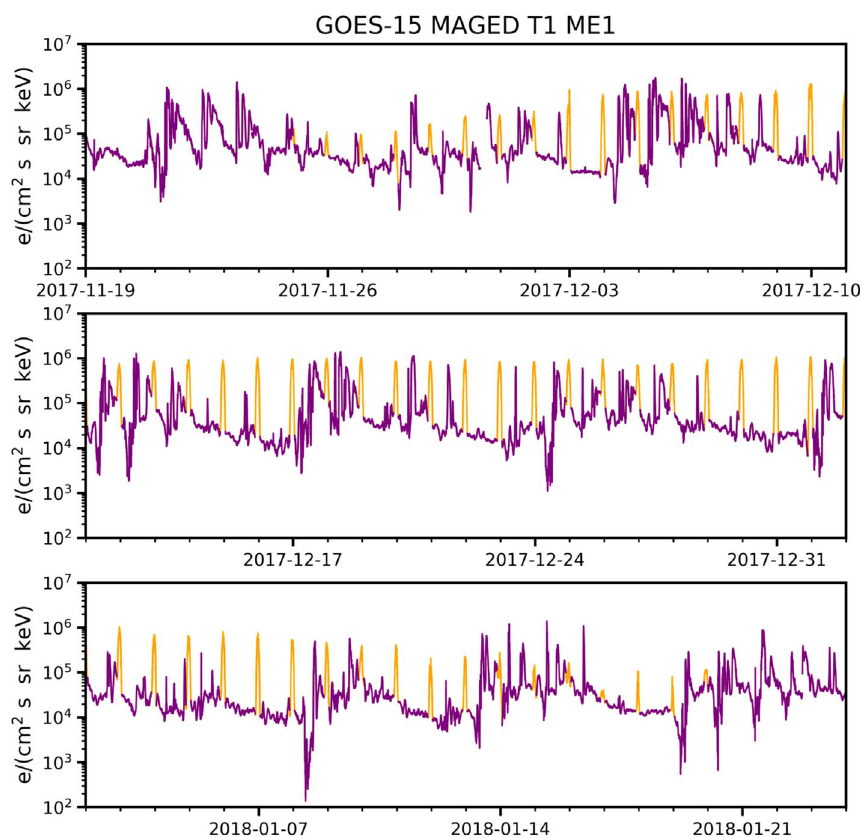
Fig. 6. GOES-15 MAGED Telescope 1 ME1 channel (40 keV electrons), 19 November 2017 – 23 January 2018. The orange traces represent the noise bursts removed from the